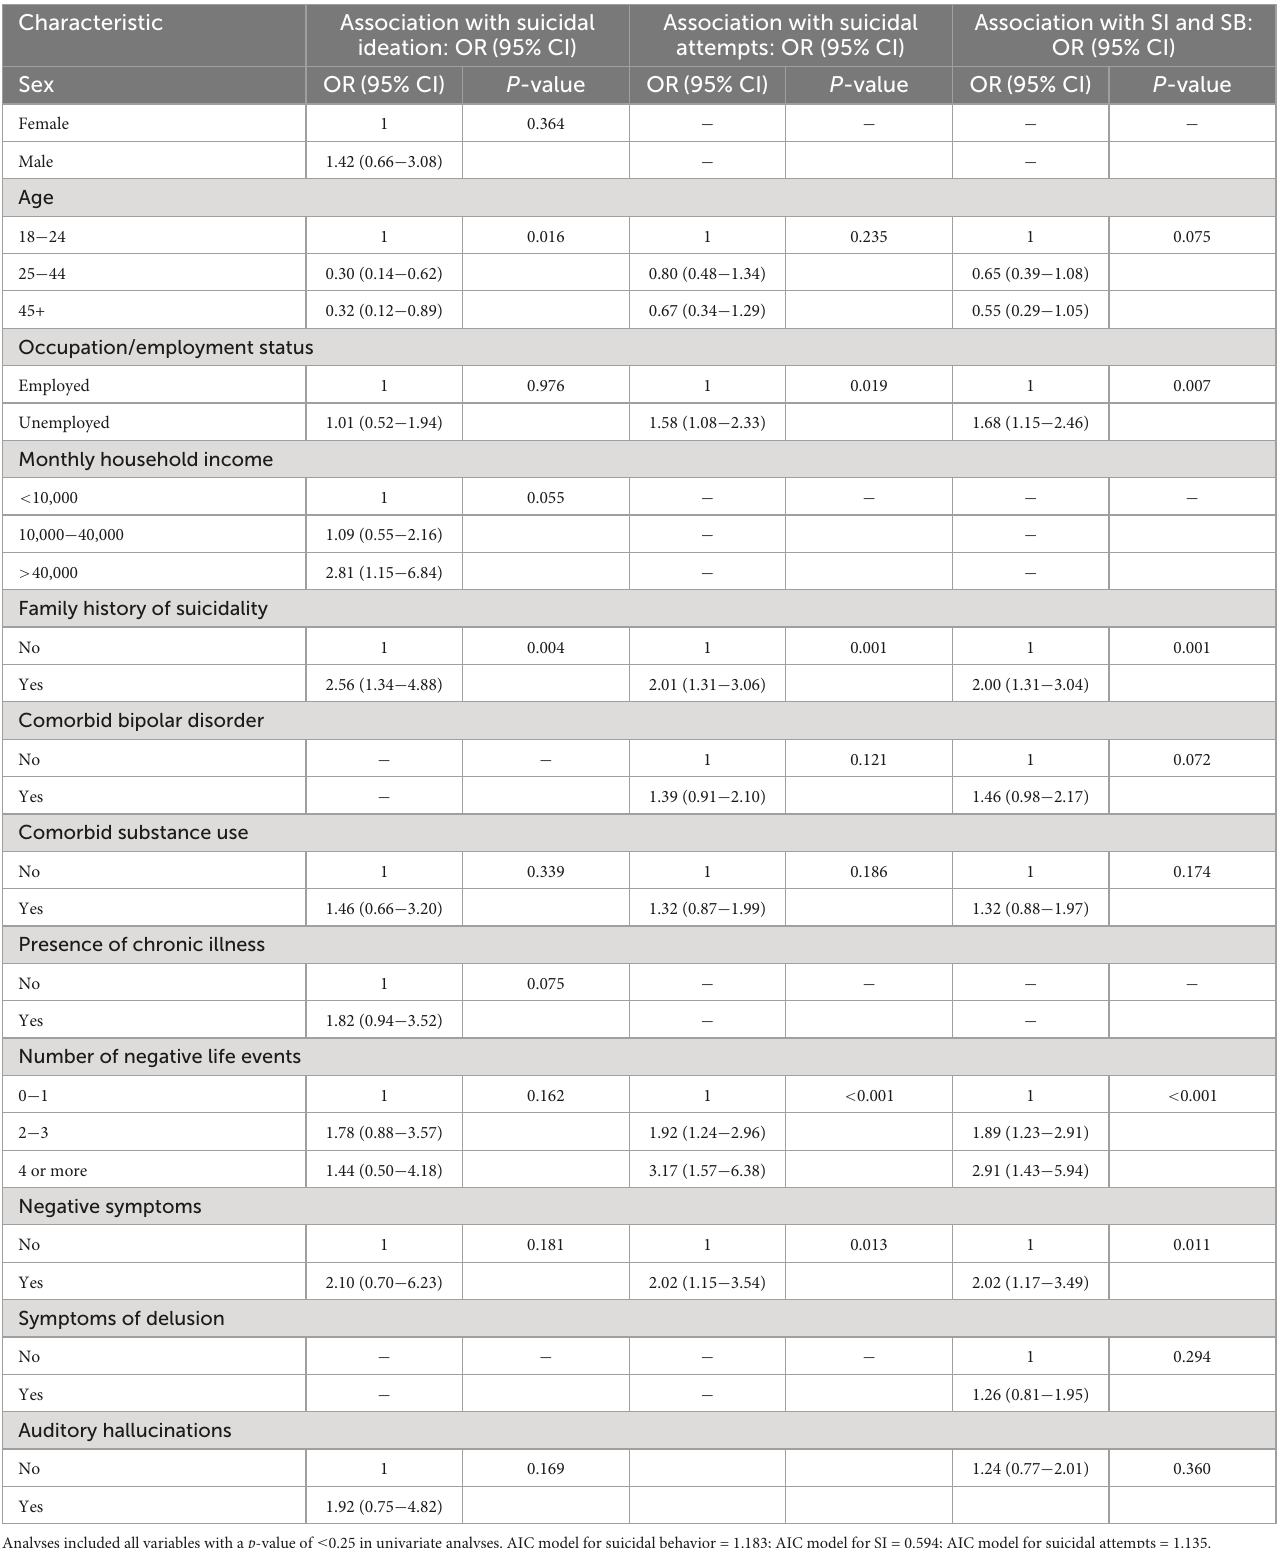
Association with suicidal Association with SI and SB: ideation: OR (95% CI) attempts: OR (95% CI) OR (95%